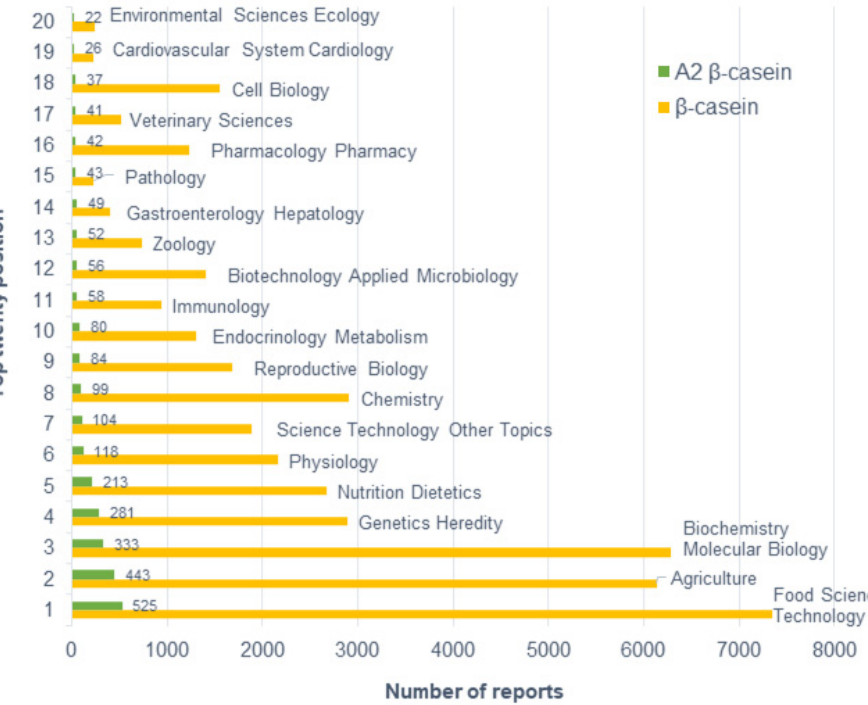
Figure 2. Distribution (number of reports) of worldwide research on β -casein and A2 β -casein by subject area, as classified by the WoS database.